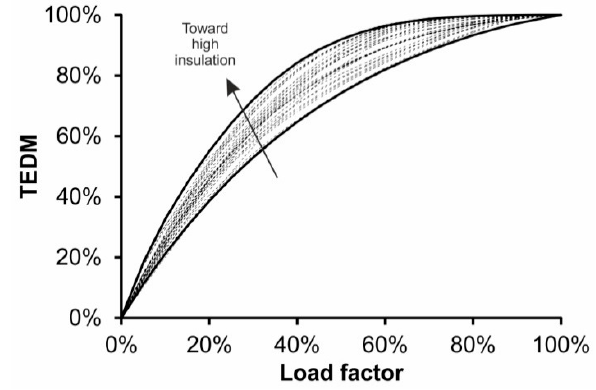
Figure 6. Load factor vs. TEDM (Total Energy Demand Met by the heat pump) in heating season for the simulations performed.